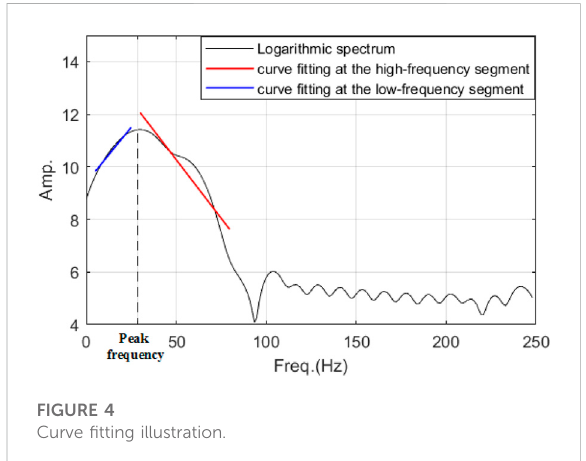
FIGURE 4 Curve fi tting illustration.